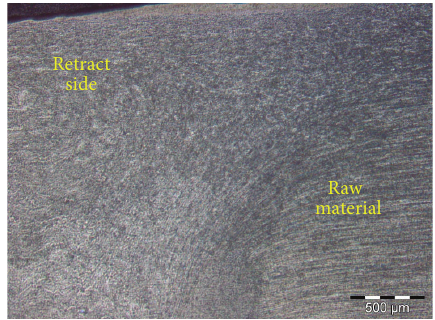
Figure 7: Metallography of FSP for CS1